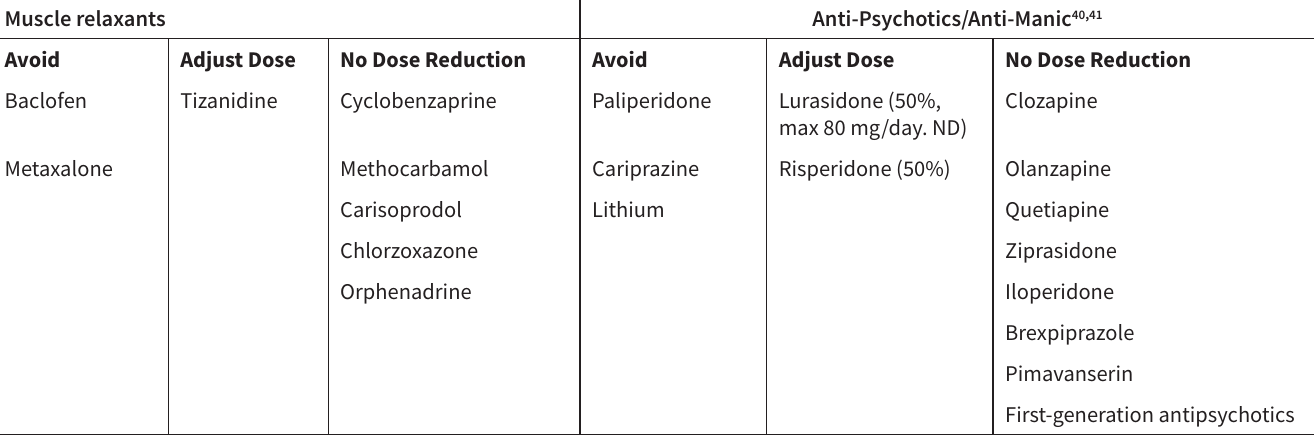
Table 3. Management of Muscle Relaxants and Anti-Psychotics in ESKD Muscle